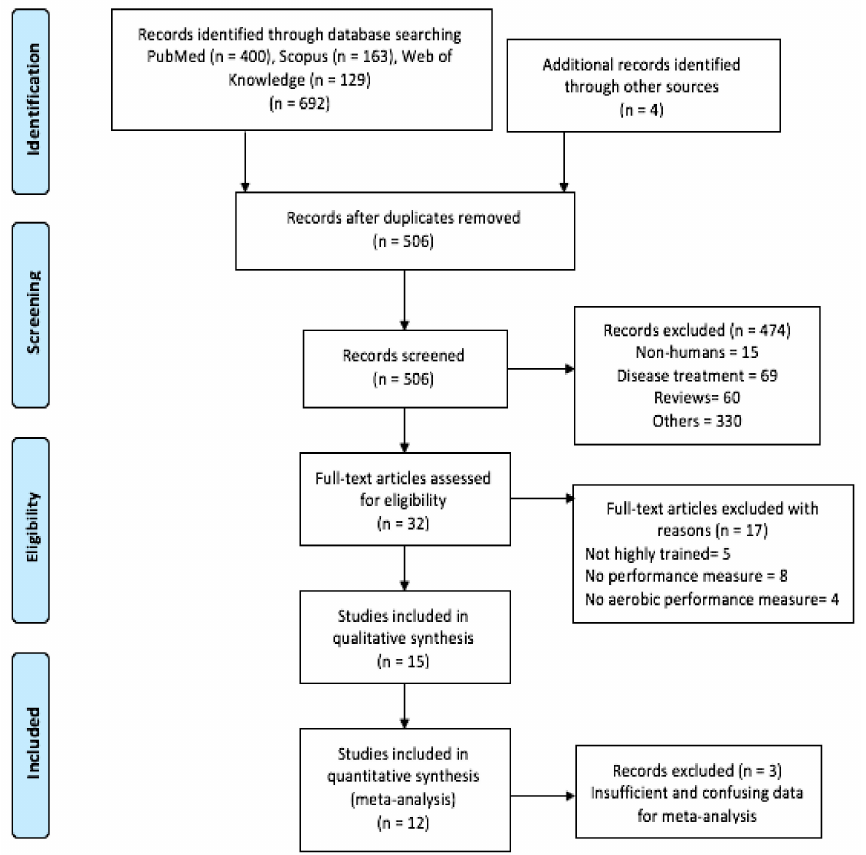
Figure 4. Preferred Reporting Items for Systematic Reviews and Meta-Analyses (PRISMA) flow diagram with information about search and screening